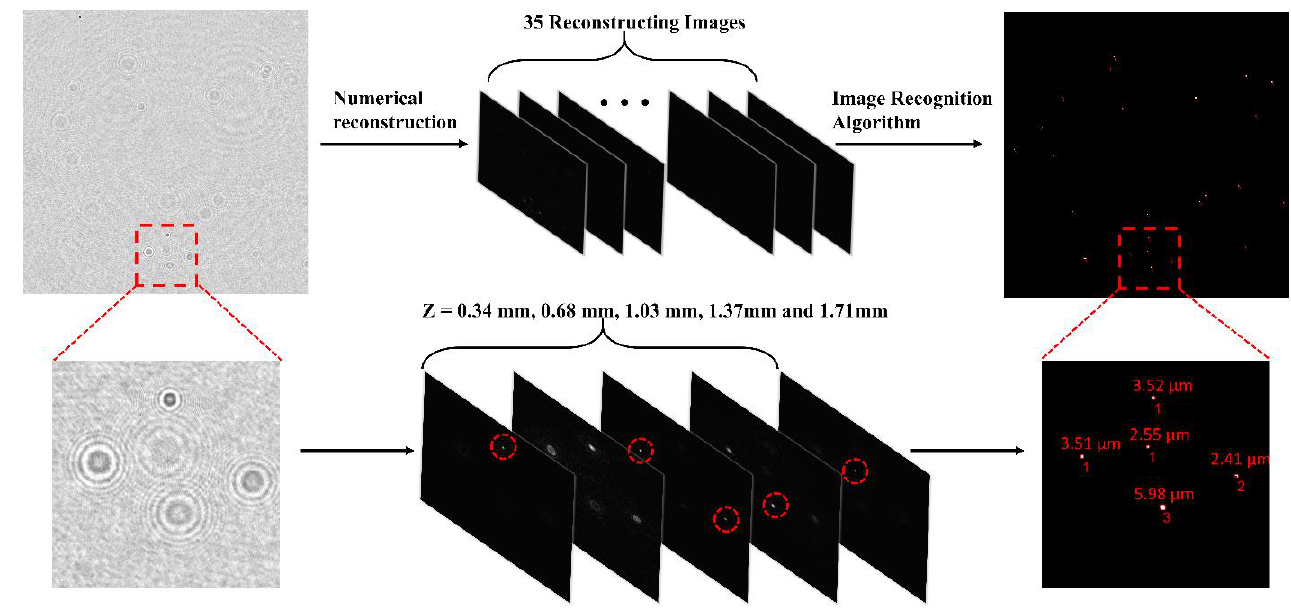
Figure 6. The schematic diagram of droplet recognition.